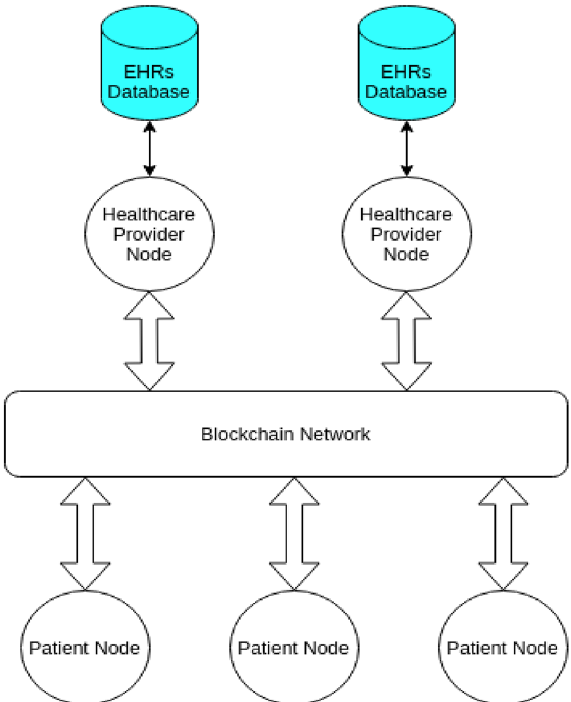
Figure 2. A simplified architecture of MedChain